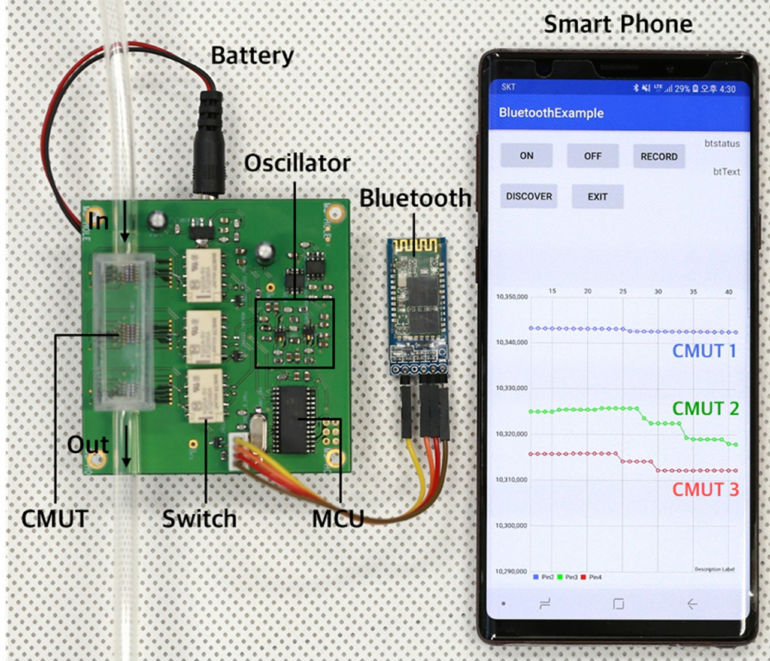
Figure 9. Photograph of the portable VOC sensor system composed of multiple CMUT sensors with multiplex detection scheme using a single read-out circuit and an electrically controlled relay. Oscillation frequencies of three CMUT sensors were simultaneously detected, transmitted, and displayed in the custom-designed Android application.